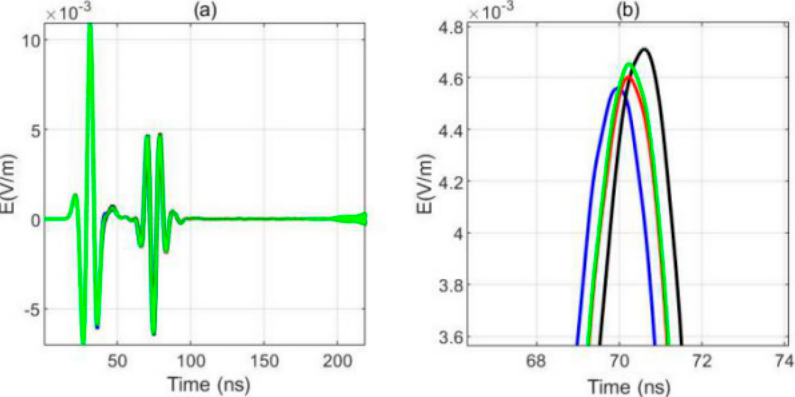
Figure 5. Waveform of a single-transmitting and four receiving signals without a borehole (blue: the east antenna; black: the west antenna; red: the south antenna, green: the north antenna) ( a )Receiving waveform, ( b ) Local amplification for ( a ) (Figure 2a).